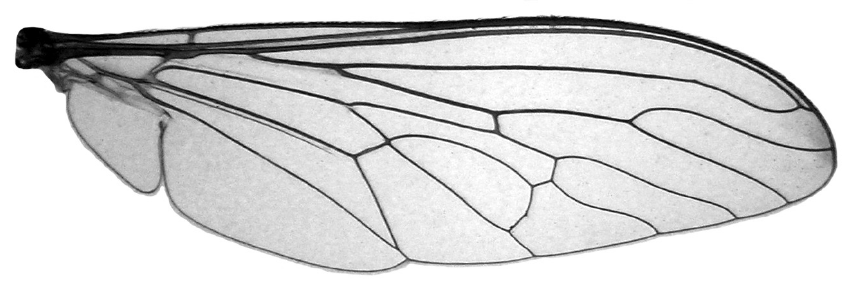
Figure 2. Gibbasilus alboala sp. n. ♂ wing (note backlighting obliterates opaque, milky basal membranes).